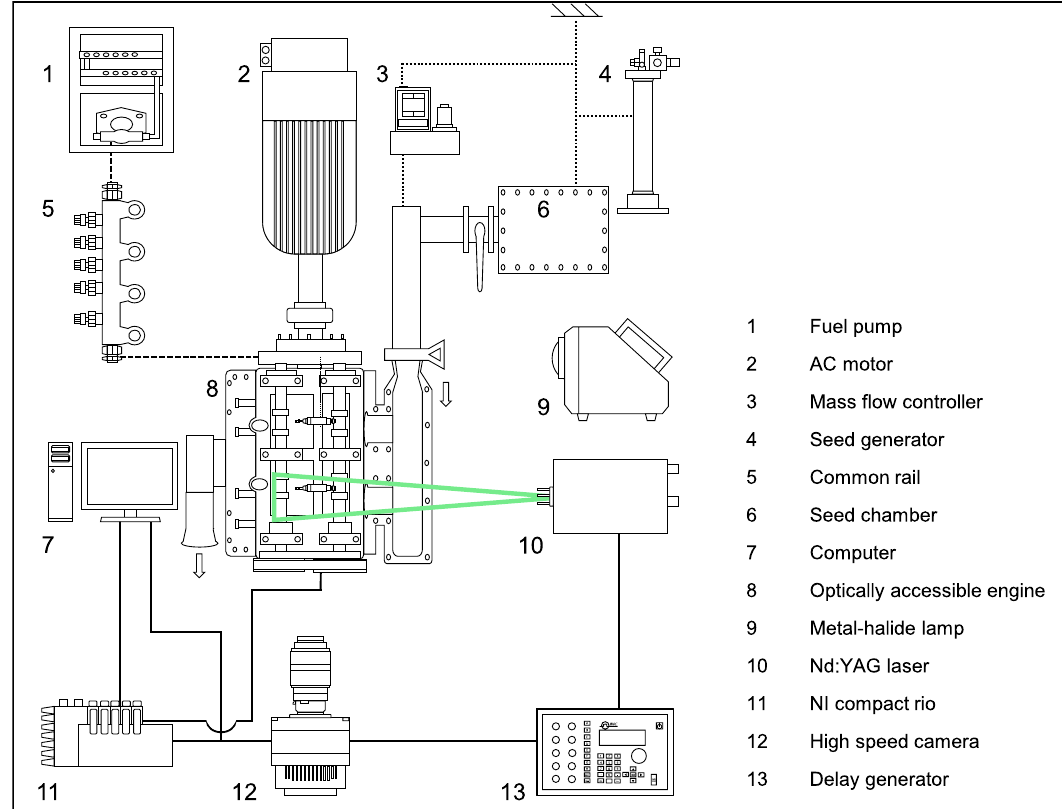
Figure 1. Schematic diagram of the engine operating